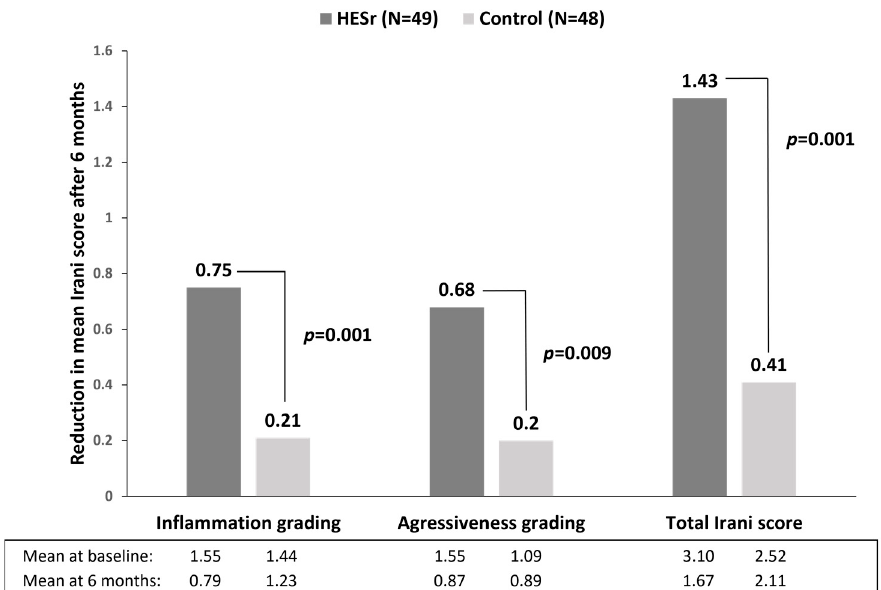
Figure 2. Histopathological findings according to Irani’s score at baseline (first prostate biopsy) and after 6 months (second prostate biopsy) [36] . The Irani score classifies prostatic inflammation on a 4-point scale based on the extension of inflammatory cells and their effect on prostate tissue. HESr—hexanic extract of Serenoa repens .